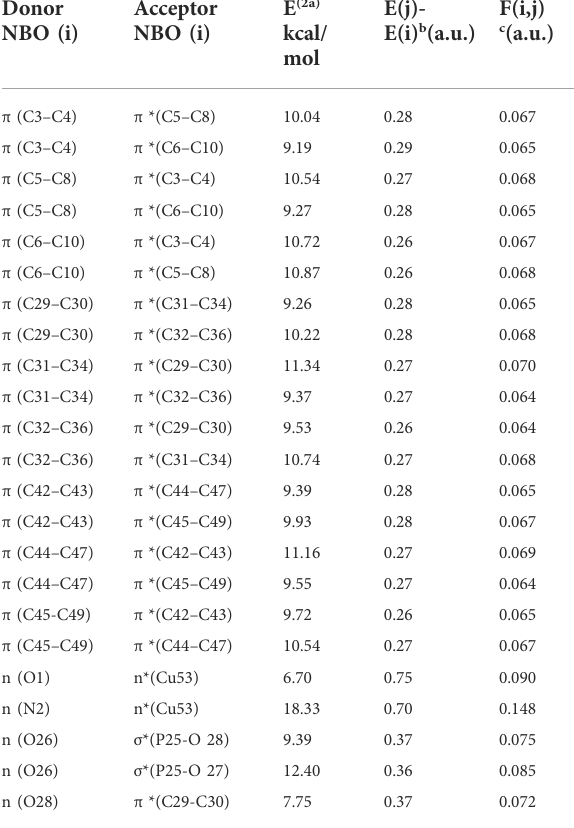
TABLE 2 Perturbation theory energy analysis of species